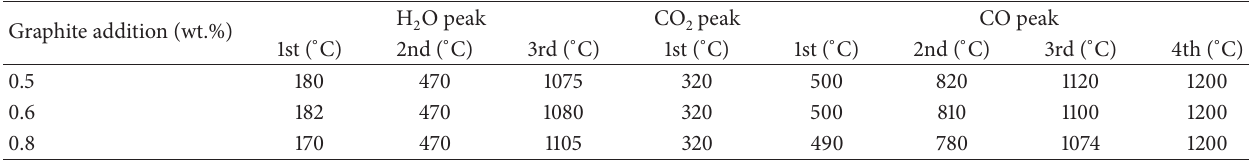
Table 9: Temperatures of the H sintered at 1200 ∘ C.